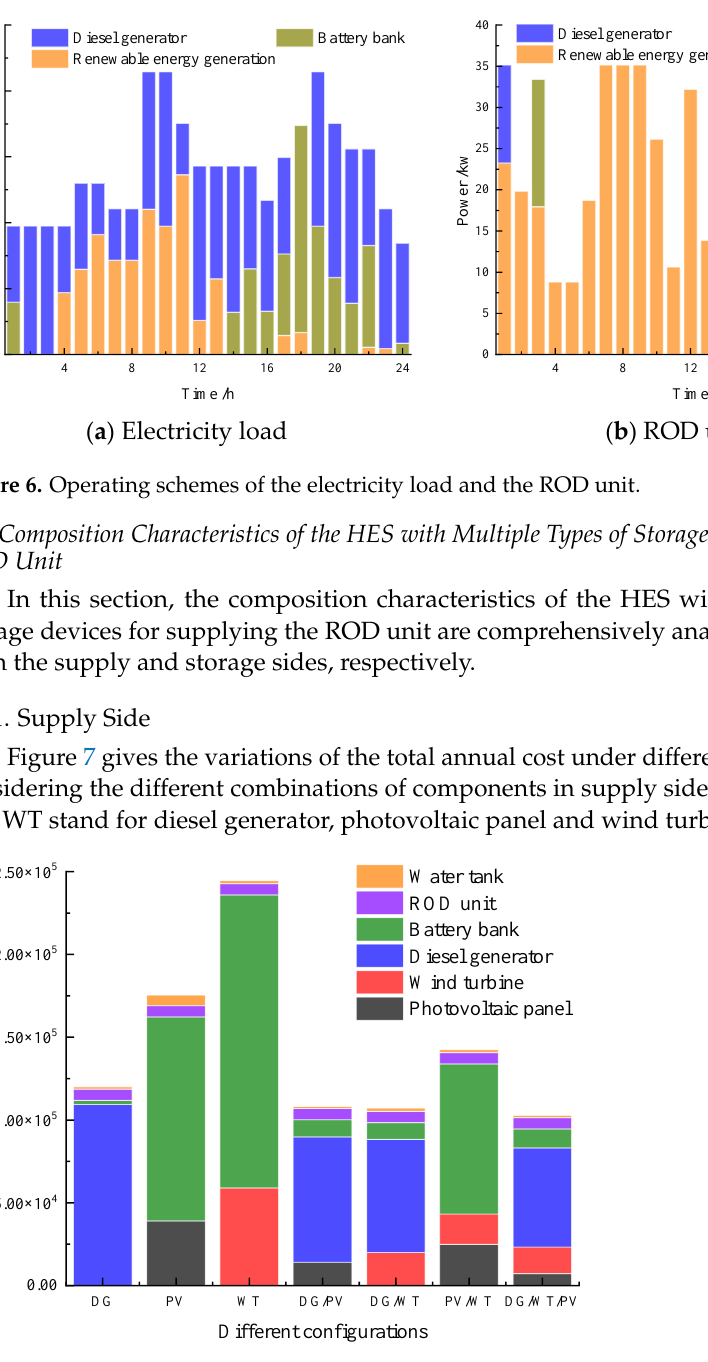
Figure 7. The variations of the total annual cost under different configurations in supply side.